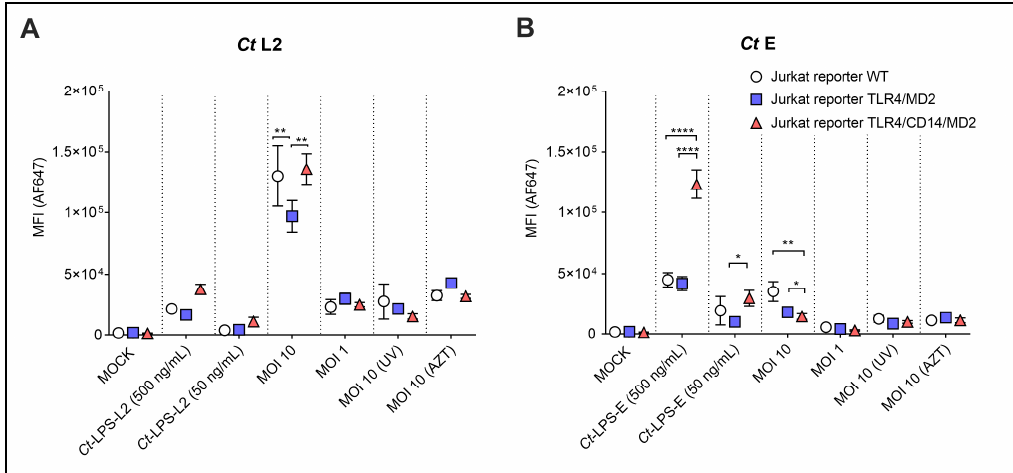
Figure 6. Analysis of uptake of Ct preparations by the different Jurkat reporter cells. WT, TLR4/MD2 or TLR4/CD14/MD2 Jurkat reporter cells were incubated for 20 h without or with monomeric Ct -LPS derived from the different Ct serovars ( Ct -LPS-L2 or Ct -LPS-E), and serovar L2 ( A ) or serovar E ( B ) in viable- (MOI 10, MOI 1), UV-treated- [MOI 10 (UV)] or AZT-treated form [MOI 10 (AZT)]. The cells were stained intracellularly with the AF647-labelled anti- c LPS mAb 512F. The data represent means ± SEM of MFI of three independent experiments. Statistical differences between the reporter cell lines (WT, TLR4/MD2 and TLR4/CD14/MD2) and the different conditions were assessed by 2way ANOVA followed by Tukey’s multiple comparisons test. * P < 0.05, ** P < 0.01, **** P < 0.0001. Only statistically significant differences between conditions are indicated. Error bars represent mean ± SEM.